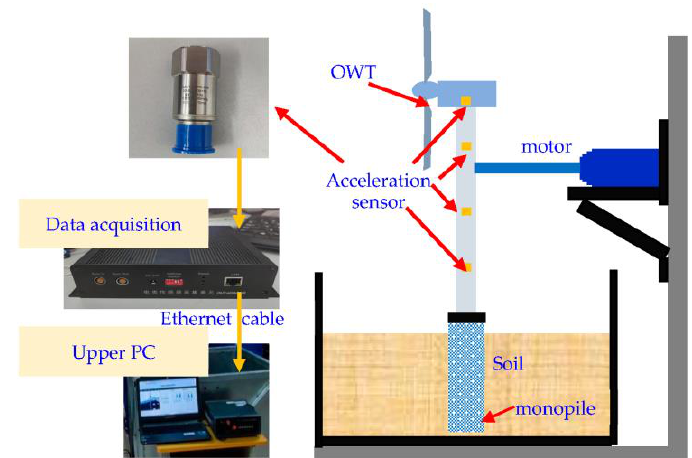
Figure 5. Experimental setup.